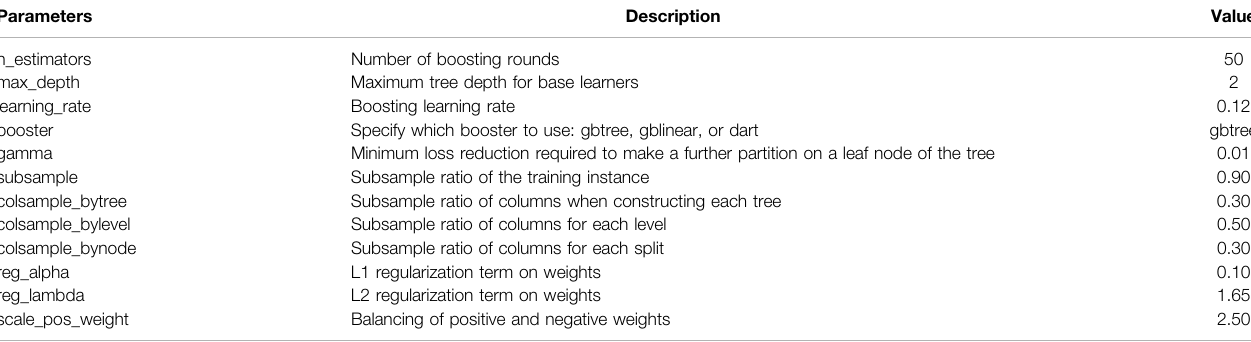
TABLE 2 | Optimal hyperparameters set of XGBoost classi fi er for leave-one-out cross-validation.